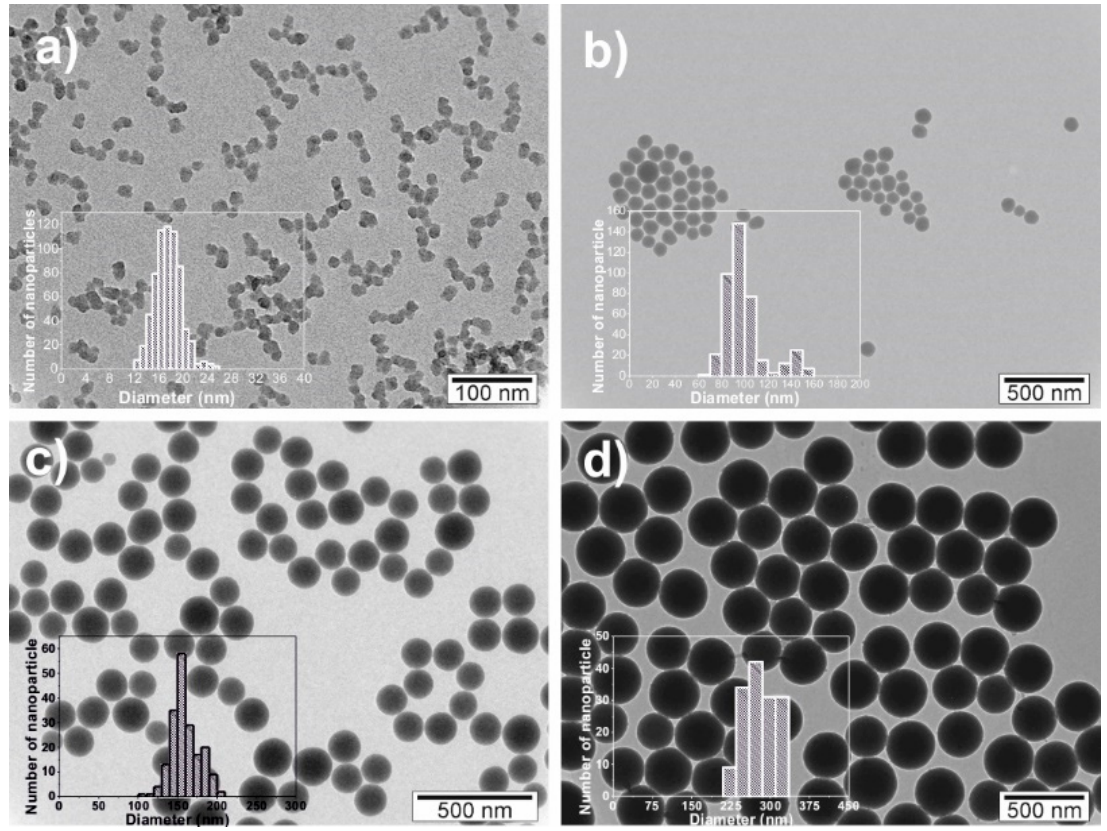
Figure 1. TEM images of SiNPs-PDI with different particle size: ( a ) 17 ± 2 nm, ( b ) 100 ± 1 m, ( c ) 160 ± 1 m and ( d ) 300 ± 3 m.